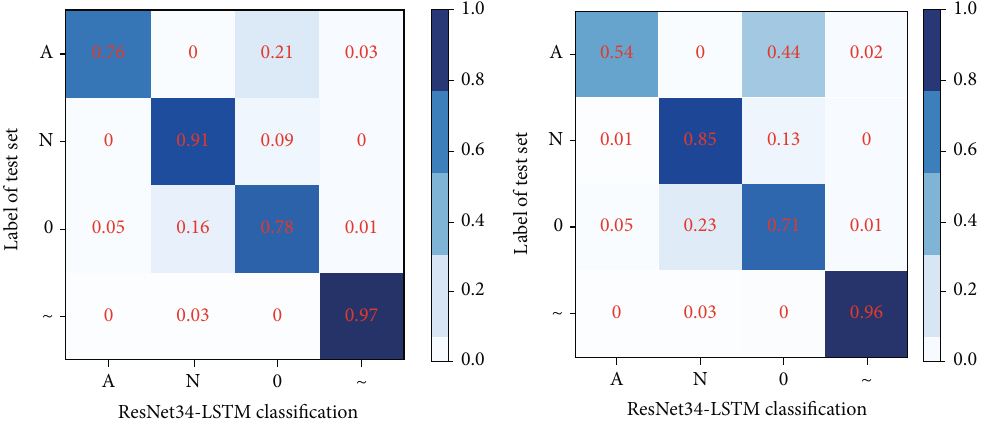
Figure 11: Comparison of the ResNet34-LSTM3 and ResNet18 confusion matrix.